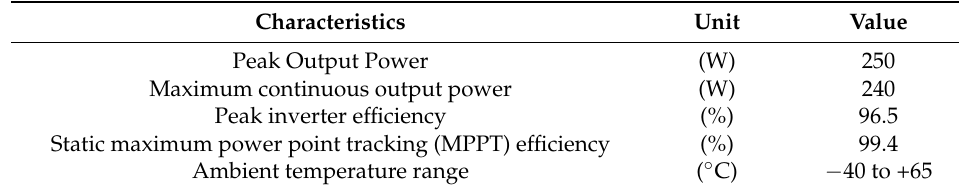
Table 3. Data acquisition technical specifications.